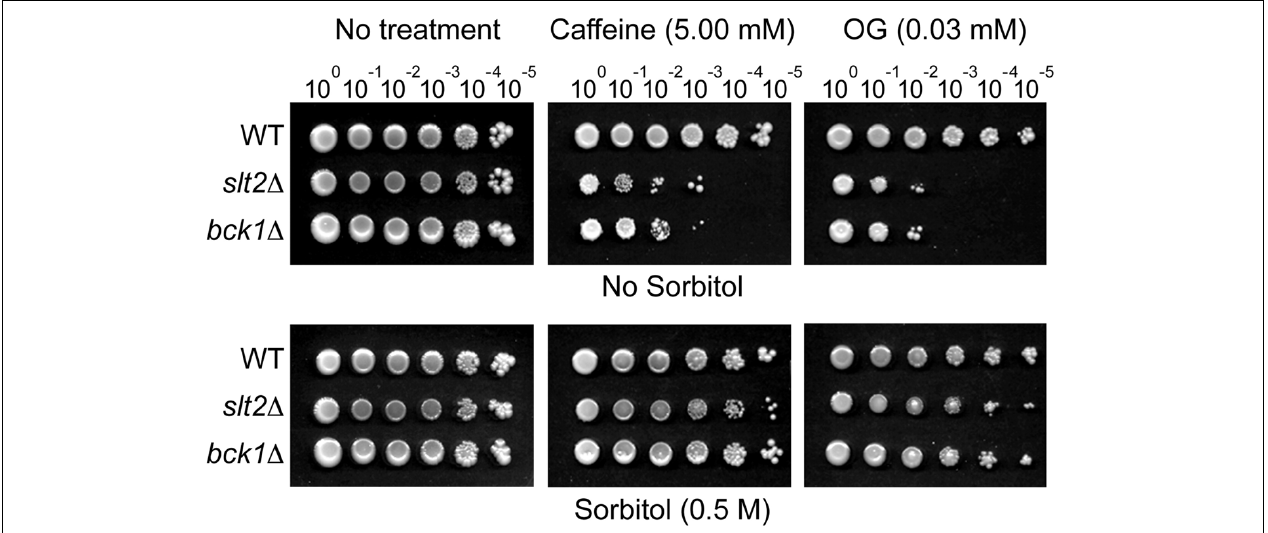
FIGURE 6 | Yeast cell-dilution bioassay showing sensitivity of S. cerevisiae slt2 (cid:2) and bck1 (cid:2) mutants to caffeine (5mM; control) and OG (0.03mM) was remediated by sorbitol. Similar remediation by sorbitol was found from treatment with higher concentration (0.04, 0.05, 0.06mM) of OG (results not shown).